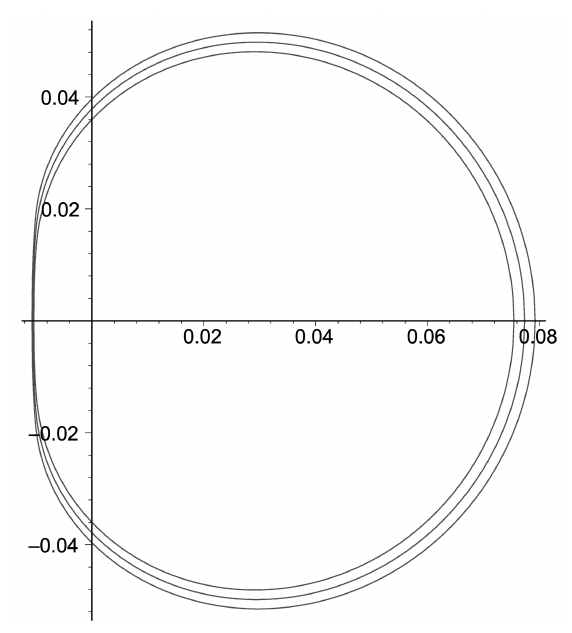
√ m 3 r and f ϑ ( ϑ ) = 0 with a constant √